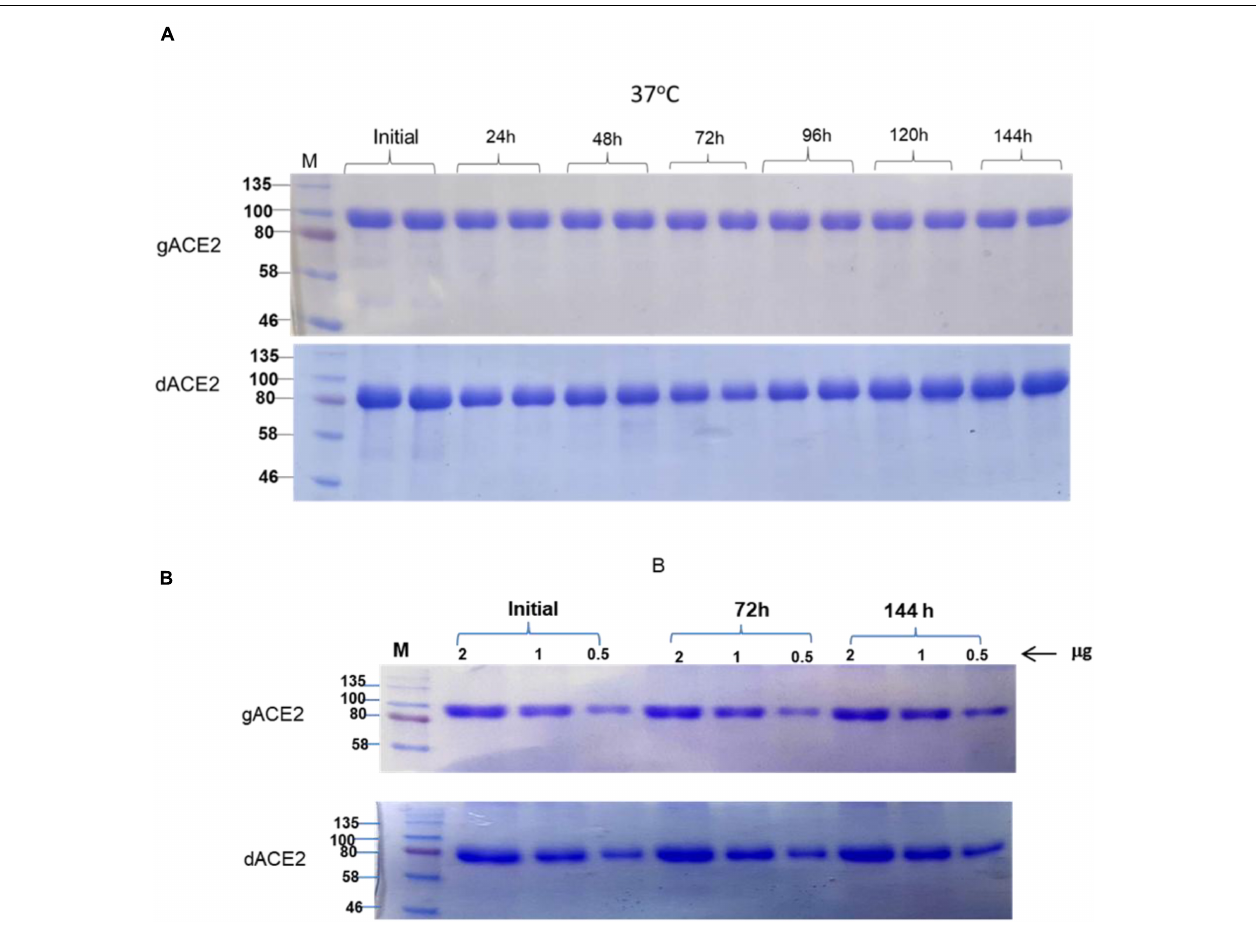
FIGURE 5 | Stability assessment of plant produced gACE2 and dACE2 proteins. (A) Plant produced, Ni-NTA resin column purified gACE2 or dACE2 variants were incubated at 37 ◦ C for 24, 48, 72, 96, 120, and 144 h, and analyzed in SDS-PAGE. Lanes were loaded with 5.0 µ g gACE2 or dACE2. (B) Plant produced, Ni-NTA resin column purified gACE2 or dACE variants were incubated for 72 and 144 h, and different amounts (0.5, 1.0, and 2.0 µ g) from each sample were analyzed in SDS-PAGE M: a color prestained protein standard (New England Biolabs, MA, United